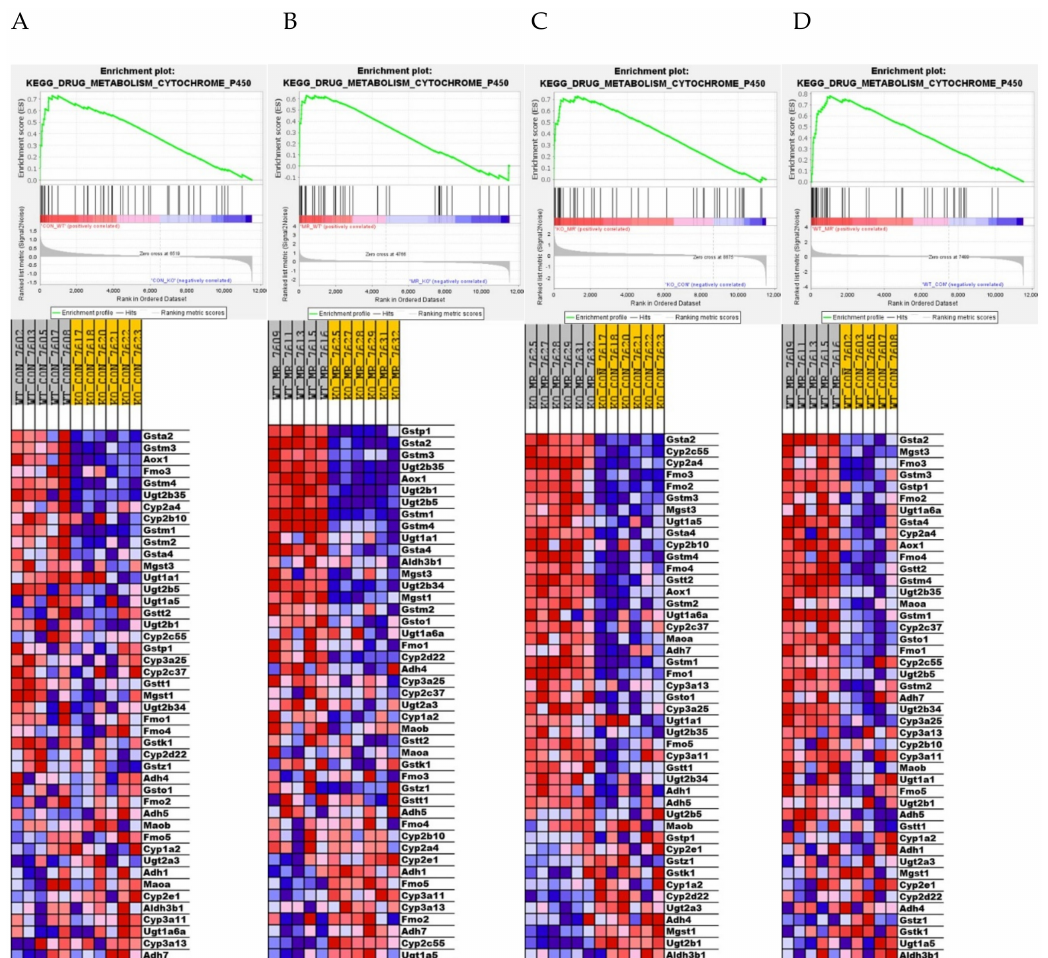
Figure 4. Gene set enrichment analysis (GSEA) of hepatic gene expression in Nfe2l2 fl/fl (WT) and Nfe2l2 fl/(Alb) ( NRF2 KO) mice showing the differential effect of genotype and diet on the top-scoring KEGG Drug Metabolism Cytochrome P450 gene set. Enrichment was computed as described in the Material and Methods and the individual contributions of pathway genes to the pathway enrichment signal were visualized via enrichment plots depicting the trajectory of a normalized pathway enrichment score against the rank of the pathway genes in the context of the full gene list. Accompanying heat maps present the normalized enrichment scores for individual genes within the gene set [blue = downregulation, red = upregulation, gray = not significant (FDR > 0.1)]. Panel ( A ) shows the enrichment set for the WT MR to WT Con comparison, panel ( B ) shows the enrichment set for the NRF2 KO MR to NRF2 KO Con comparison, panel ( C ) shows the enrichment set for the WT MR to NRF2 KO MR comparison, and panel ( D ) shows the enrichment set for the WT Con to NRF2 KO Con